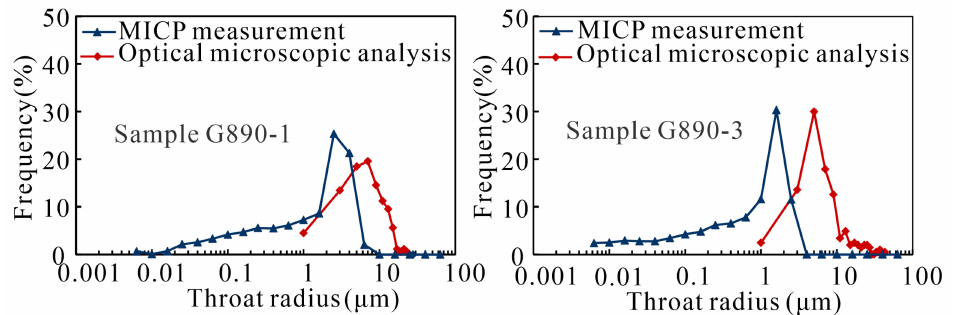
Figure 14. Comparison of throat size distribution derived from MICP and photomicrograph analysis. However, the overall trends in pore sizes revealed by optical photomicrograph anal- ysis, MICP, and NMR are the same (Figures 14 and 15A,B). Regression analysis shows that the T 2 relaxation times ( T 2max and T 2mid ) are consistent with the corresponding pore throat radius derived from MICP data. In general, T 2max and T 2mid increase with increasing pore throat radius (maximum pore throat radius ( R max ) and median pore throat radius ( R 50 )), with good exponential correlations (Figure 15A,B), confirming the applicability of using NMR T 2 relaxation times to calculate pore sizes. Due to the shielding effect of large throats caused by Haines jump, the correlation between the T 2max and maximum pore throat radius ( R max ) is relatively weak (R 2 = 0.67; Figure 15A).